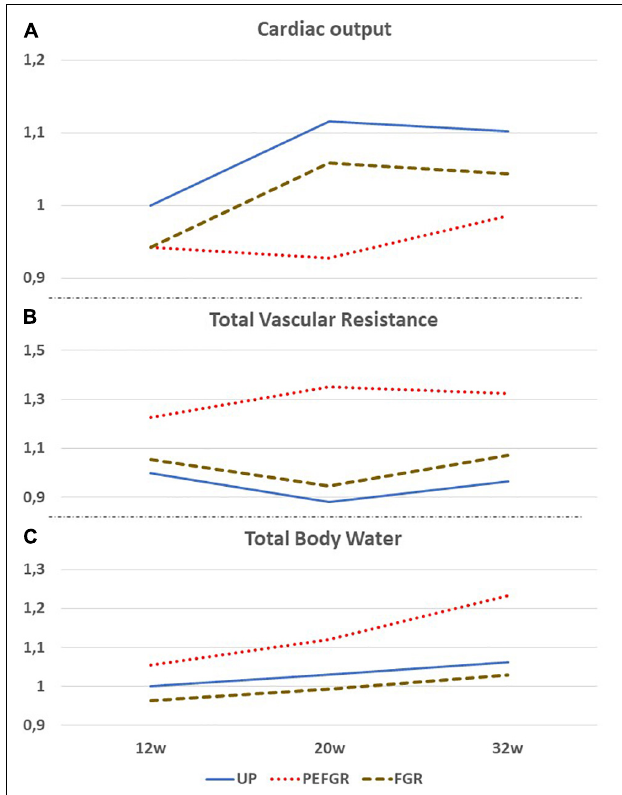
FIGURE 1 | Comparative gestational evolution of maternal cardiac output (A) , total vascular resistance (B) , and total body water volume (C) , as measured by the bioimpedance technology between uncomplicated pregnancies (UP), normotensive fetal growth restriction (FGR), and preeclampsia with FGR (PEFGR). Values are expressed as multiples of mean first trimester values in UP. Figures adapted from 10, 11, and